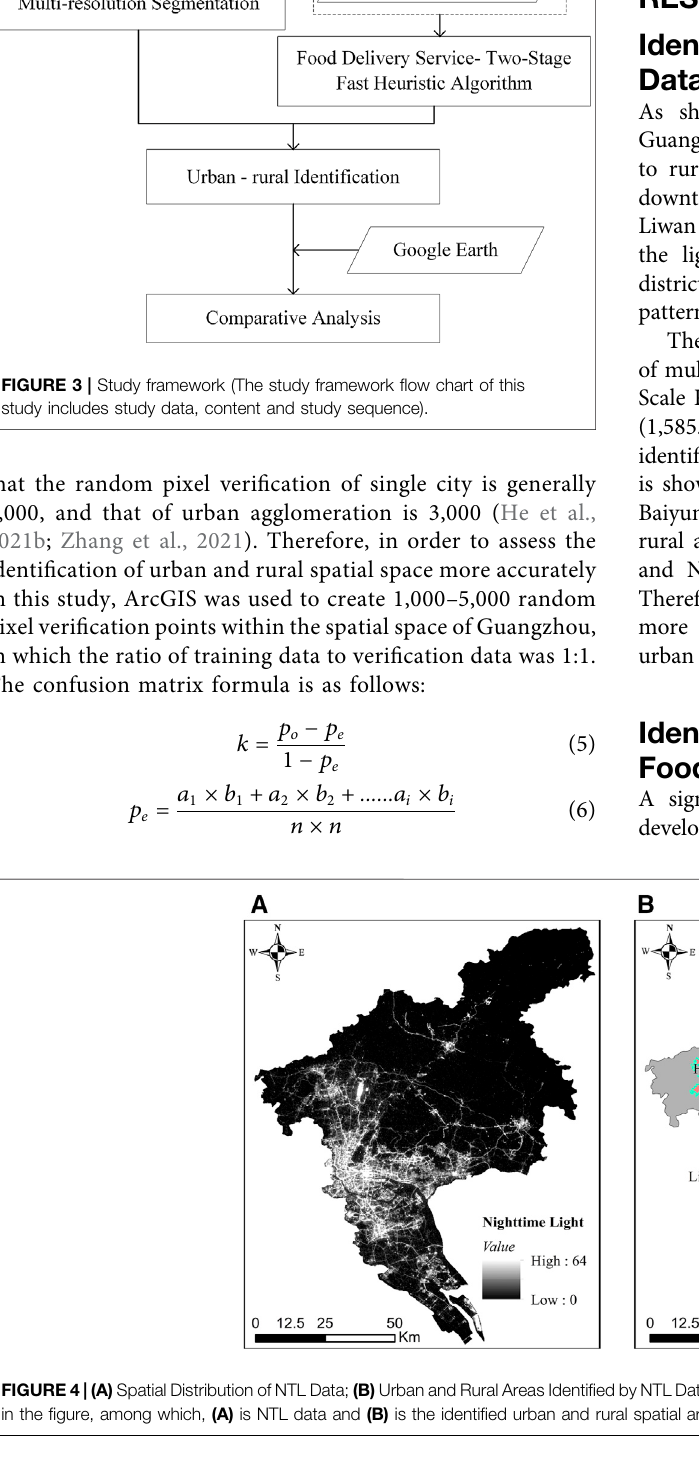
Frontiers in Earth Science |